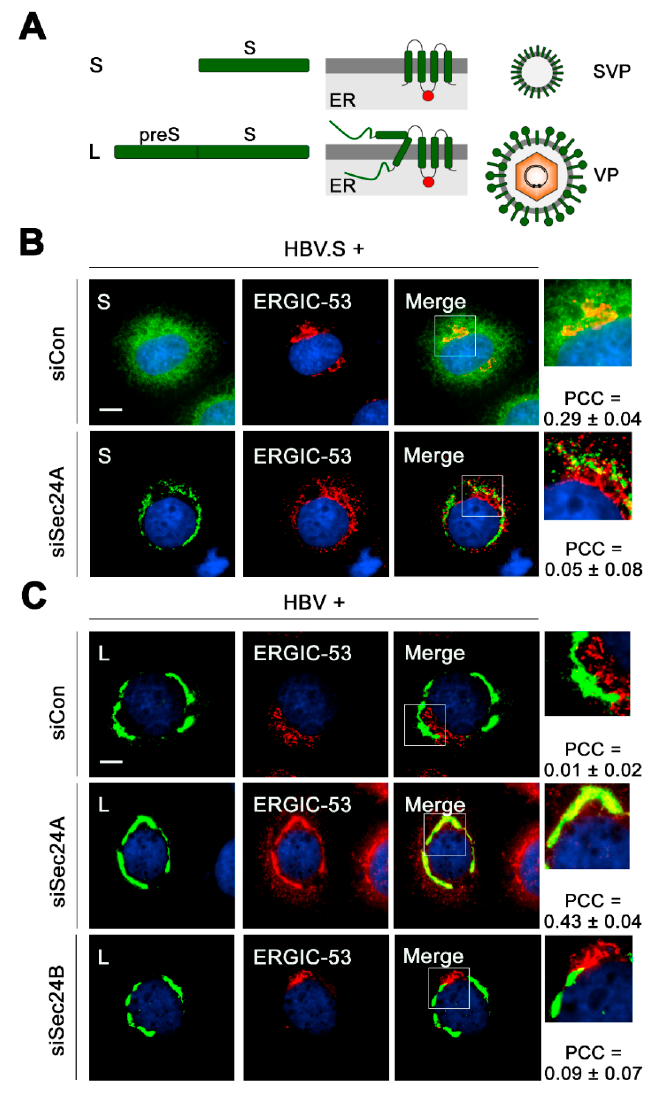
Figure 4. Viral HBV L, but not subviral HBV S, colocalizes with ERGIC-53 upon ER export block. ( A ) Domain structures of the S and L proteins (left), their transmembrane topology at the ER (middle) and HBV subviral particle (SVP) and VP types (right). The red circles depict the N-glycan acceptor N146. ( B , C ) Cells were treated with the indicated RNA duplexes for 2 days and retransfected with pHBV.S ( B ) or pHBV* ( C ). After an additional two days, cells were fixed with PFA and stained with either rabbit anti-S (K38, S, green) ( B ) or rabbit anti-L (57761, L, green) ( C ) plus mouse anti-ERGIC-53 (red) antibodies. DNA staining is shown in blue. Overlaid images (yellow) are displayed in the Merge panels with magnifications and PCC data. Bar, 10 µ